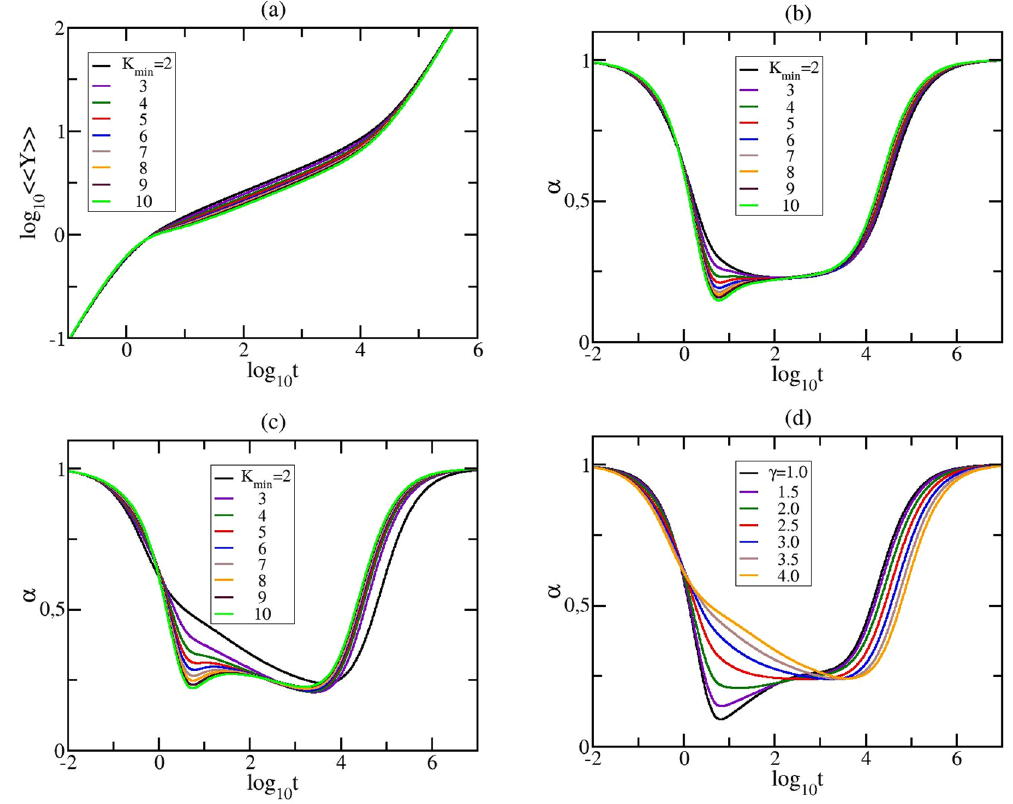
Figure 8. The average monomer displacement and its derivative for GSFPNs with N = 4000. The above row ( a ) and ( b ) corresponds to γ = 2.5, K max = N − 1. In panel ( c ) the fixed parameters are: γ = 4.0 and K max = 3999 and in panel ( d ) we have K max = 200 and K min =